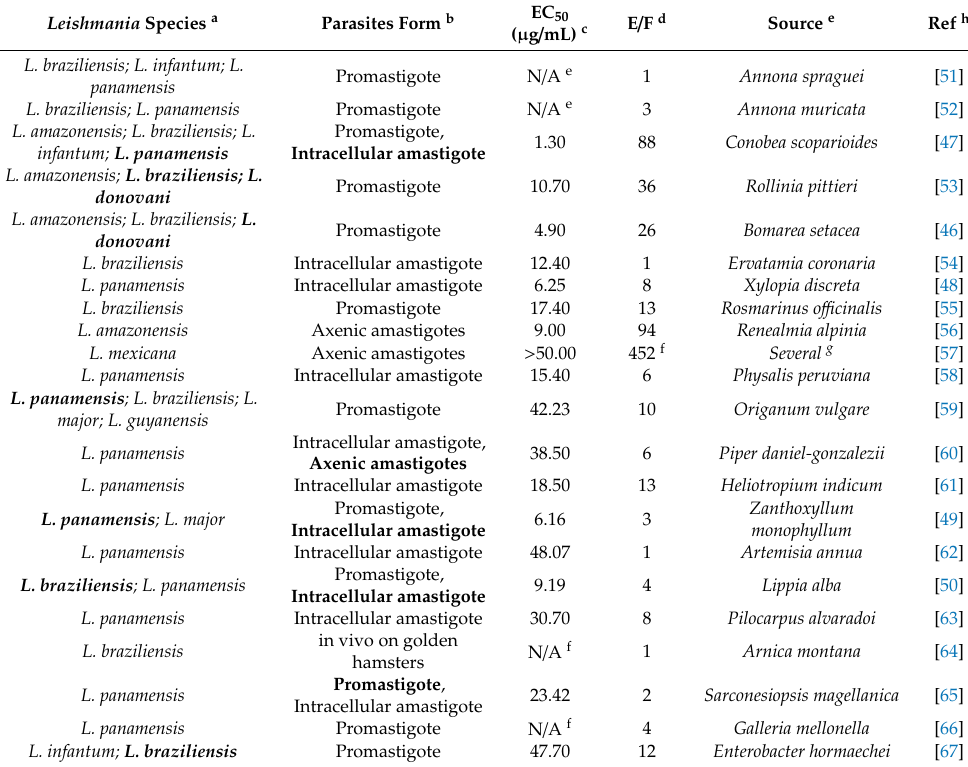
Table 1. Summary of the antileishmanial potential of crude extracts retrieved from the articles included in this systematic